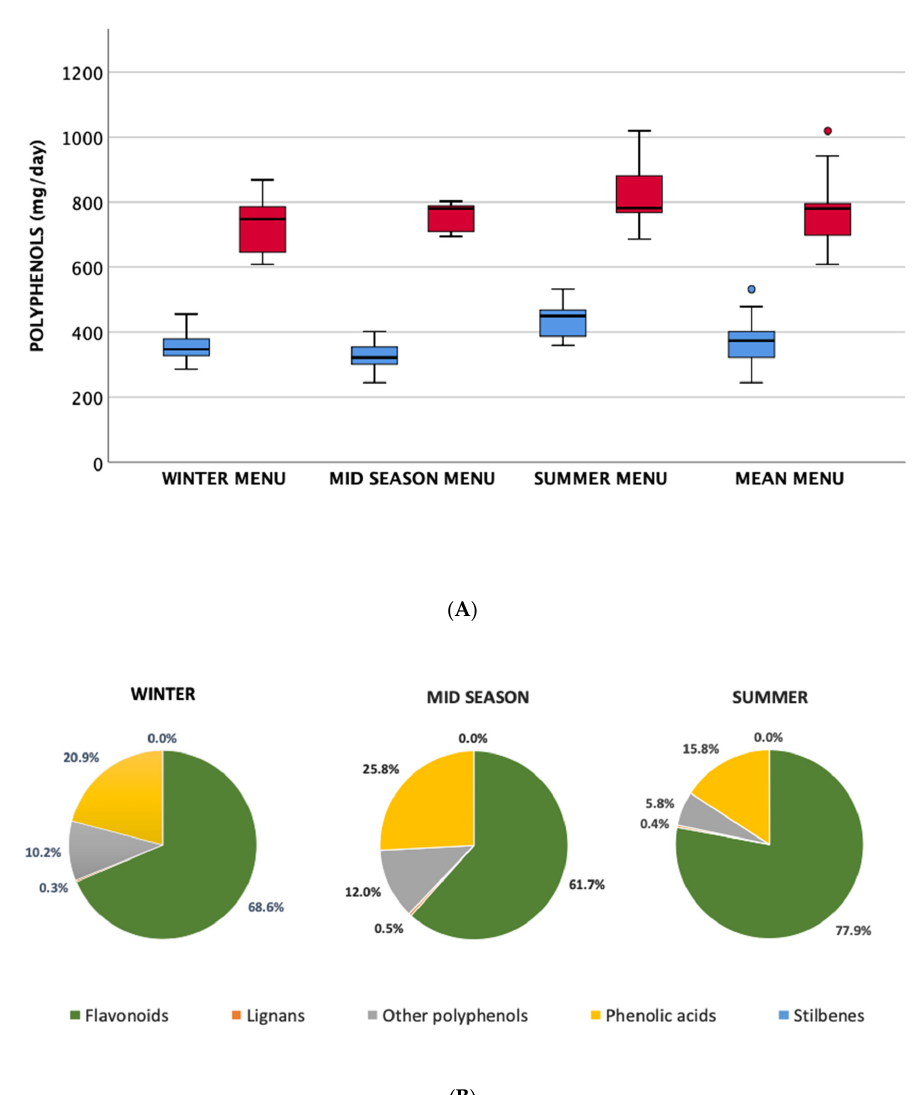
Figure 1. Box plot (panel A ) showing polyphenol content in the seasonal menus, estimated through PE/USDA databases and other published data (TP in light blue) and by Folin–Ciocalteau data as reported in the PE database and other sources (TPC in red); percentage distribution of polyphenol classes (panel B ) in the seasonal menus. Dots represent mild outliers that are more extreme than Q1 - 1.5 * IQR or Q3 + 1.5 * IQR but are not extreme data (where Q1=quartile 1; Q3=quartile 3; − 1.5 * IQR or Q3 + 1.5 * IQR but are not extreme data (where Q1 = quartile 1; Q3 = quartile IQR=interquartile range). Q1